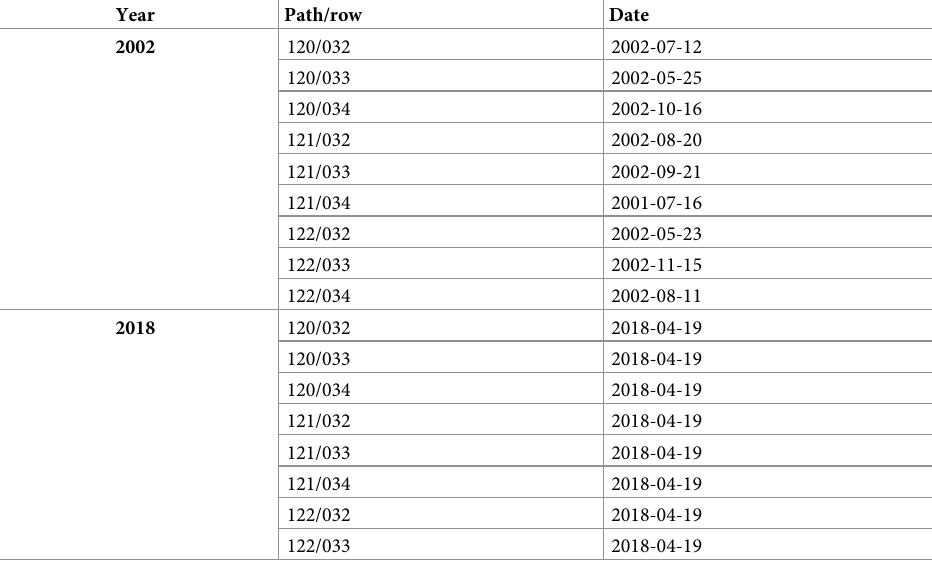
Table 1. Path/Row and date of Landsat remote sensing images used in the